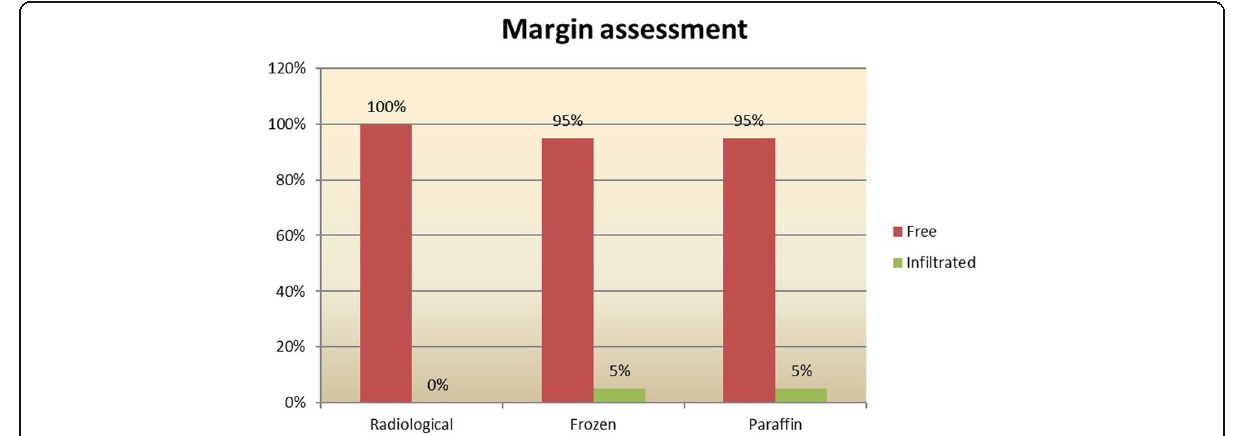
Fig. 8 Graph showing margin assessment radiologically, frozen section, and paraffin section